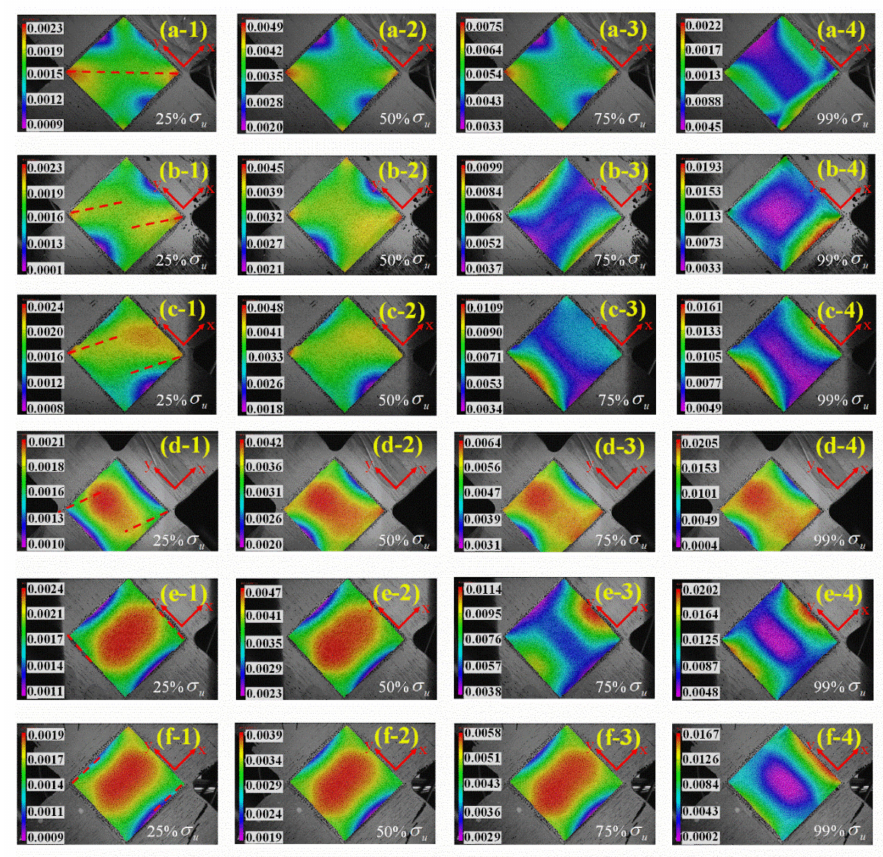
Figure 11. Maximum principal strain distribution of the effective test region with the loading ratio in X and Y axes by ( a ) 3:1, ( b ) 2:1, ( c ) 1:1, ( d ) 0.67:1, ( e ) 1:0, ( f )